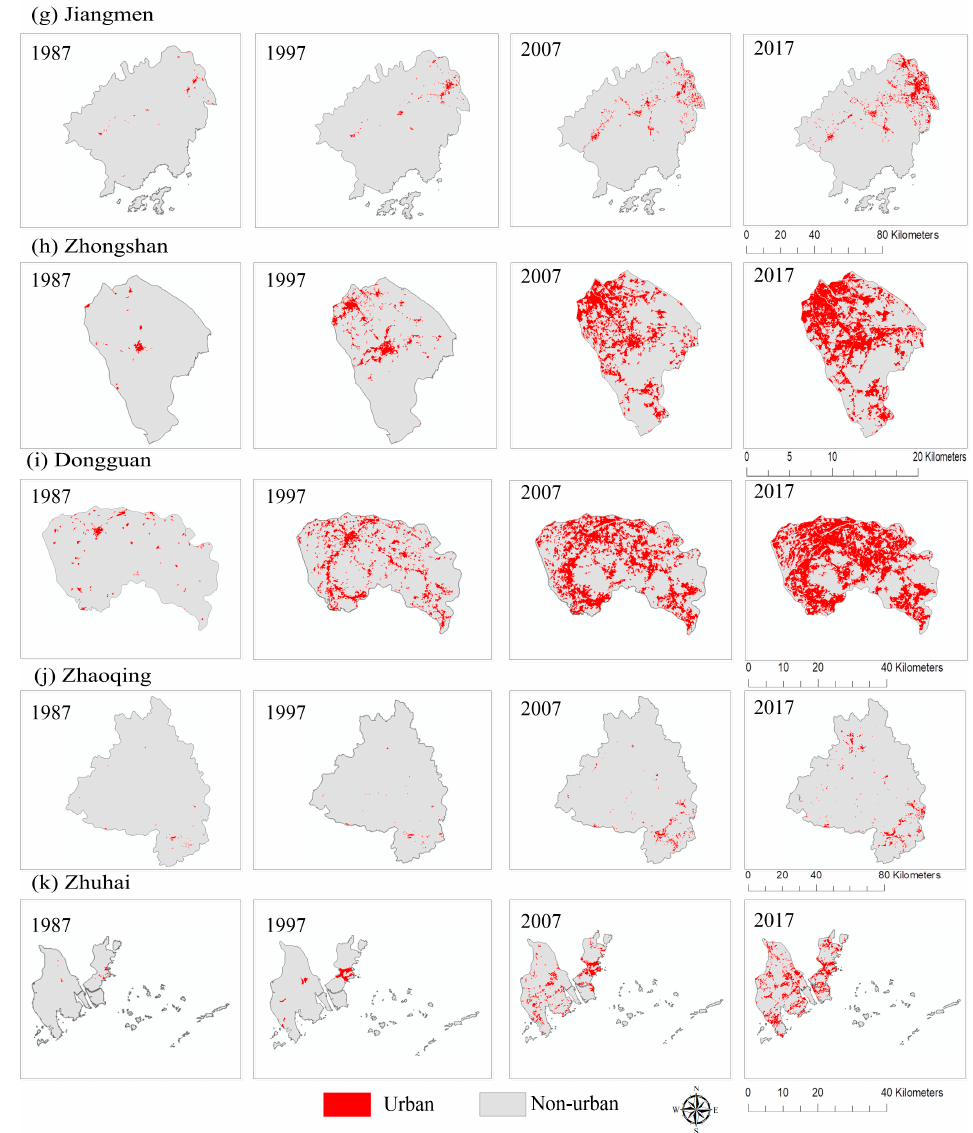
Figure 3. ( Continued ). Figure 3. The urban areas of 11 cities within the Greater Bay Area (GBA) from 1987 to 2017. Table 5. The evolution of the urban area in 11 cities in the GBA from 1987 to 2017 (km 2 ). Study Areas Urban Areas